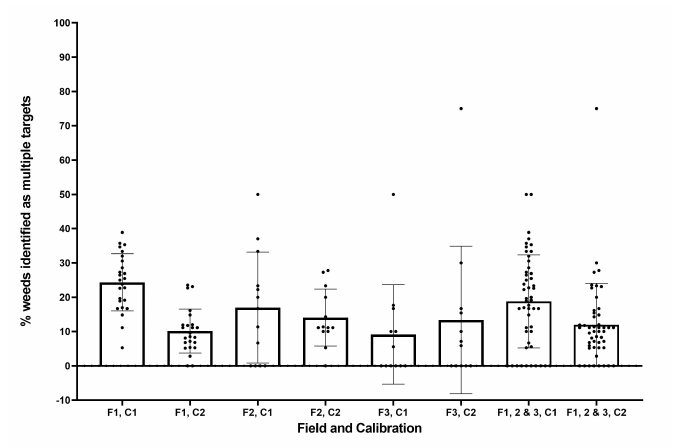
Figure 11. Proportion of weeds identified as multiple targets for each field (F1–3) and calibration (C1, C2).